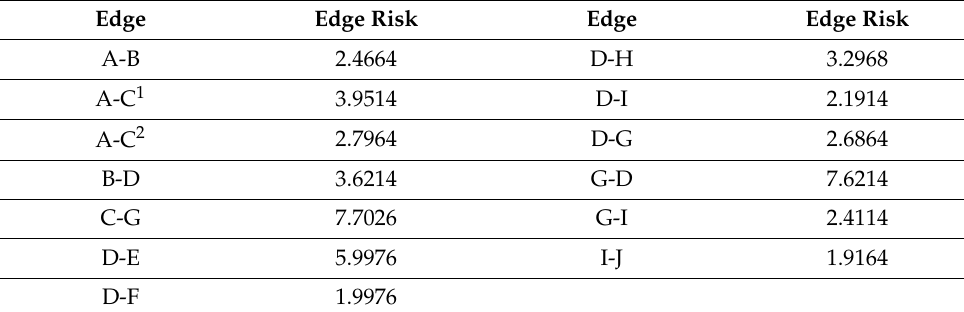
Table 7. Edge risk calculation results.